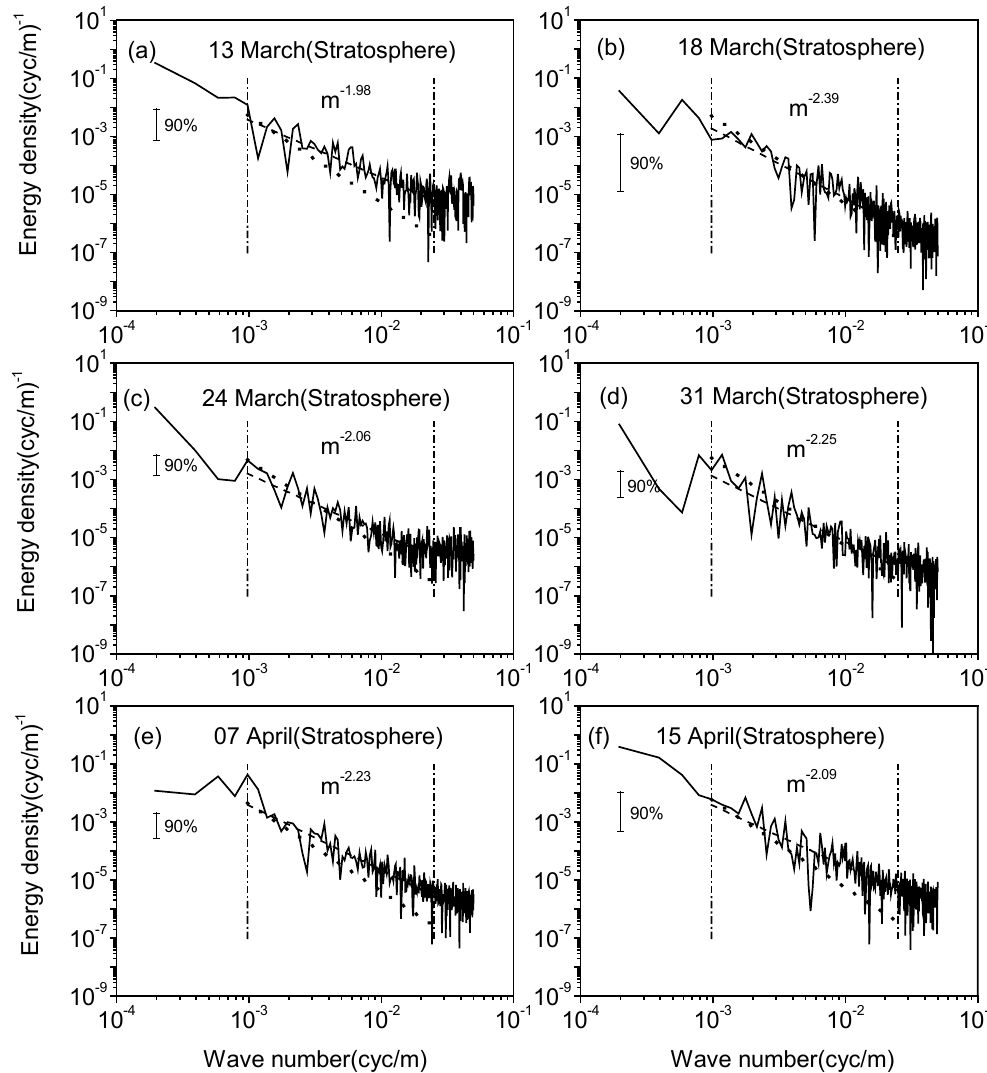
Fig. 3. As in Fig. 2, but for balloon measurements in the lower stratosphere.